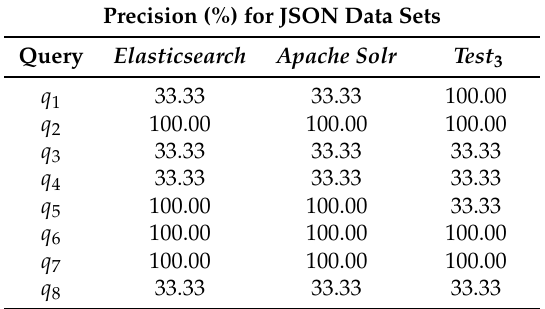
Table 3. Precision comparison of Test 3 with the baselines obtained by means of Elasticsearch and Apache Solr (for JSON Data Sets).